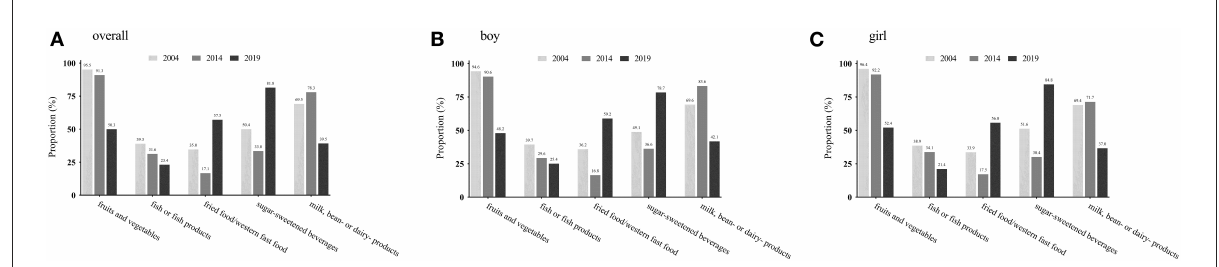
FIGURE3 Prevalence of each ideal healthy diet component in total population and subgroups of sex: 2004–2019. (A–C) Stand for the prevalence of each ideal healthy diet component in overall population, boys, and girls, respectively.